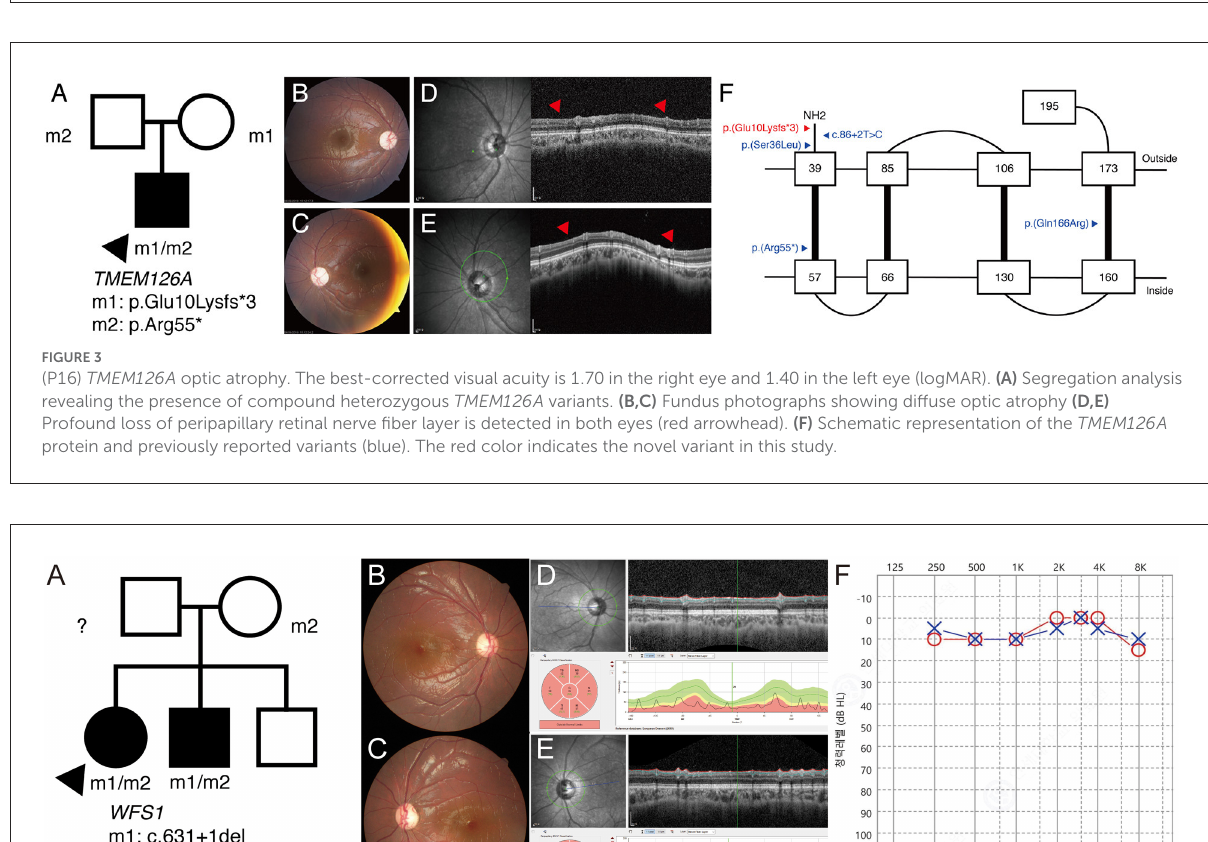
The location of this novel variant is indicated in a schematic representation of the TMEM126A protein comparing previously reported variants (Figure